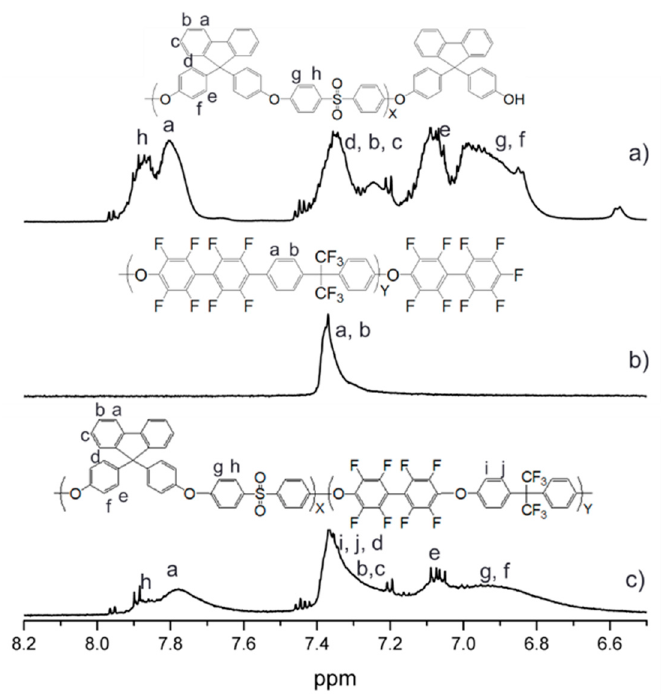
Figure 2. 1 H NMR of ( a ) PAS-X10, ( b ) PAE-Y13, and ( c ) PAES X10Y13. Table 1. Repeat units, molecular weights ( M n and M w ) and PDI ( M w / M n ) of PAS and PAE oligomers. Polymer